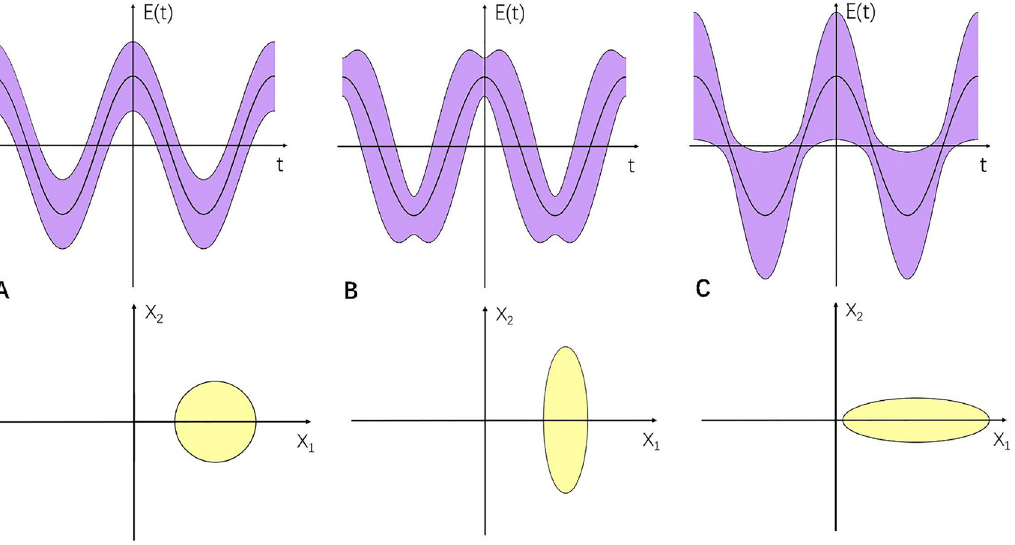
Figure 24: Diagrams of electric field versus time and the corresponding error area in three states. (A) A coherent state. (B) A squeezed state reducing the uncertainty in X . (C) A squeezed state reducing the uncertainty in X 1